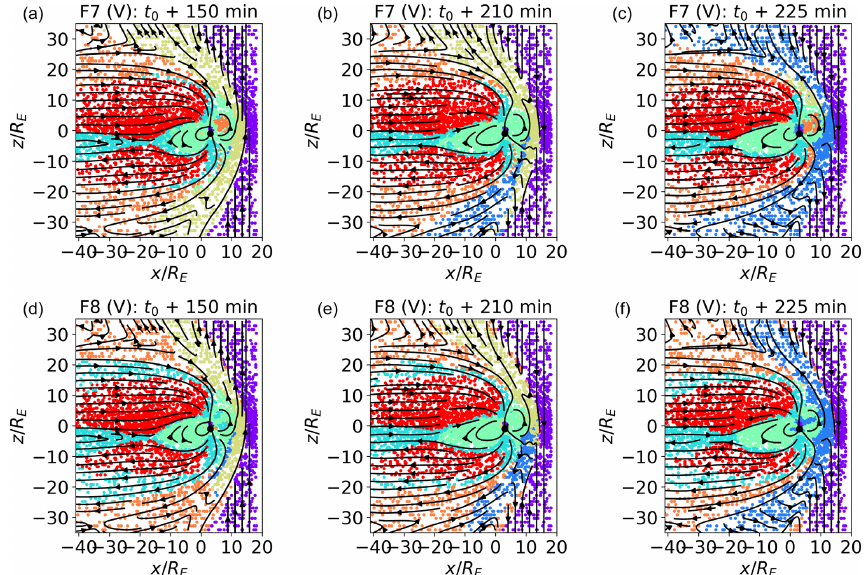
Figure 9. Classification of validation data sets. y/R E = 0 plane at t 0 + 150, 210, and 225min for maps trained with the F7 and F8 feature sets. In F7, B x , B y , and B z are not used for the map training. In F8, B x , B y , and B z are clipped as described in Sect.